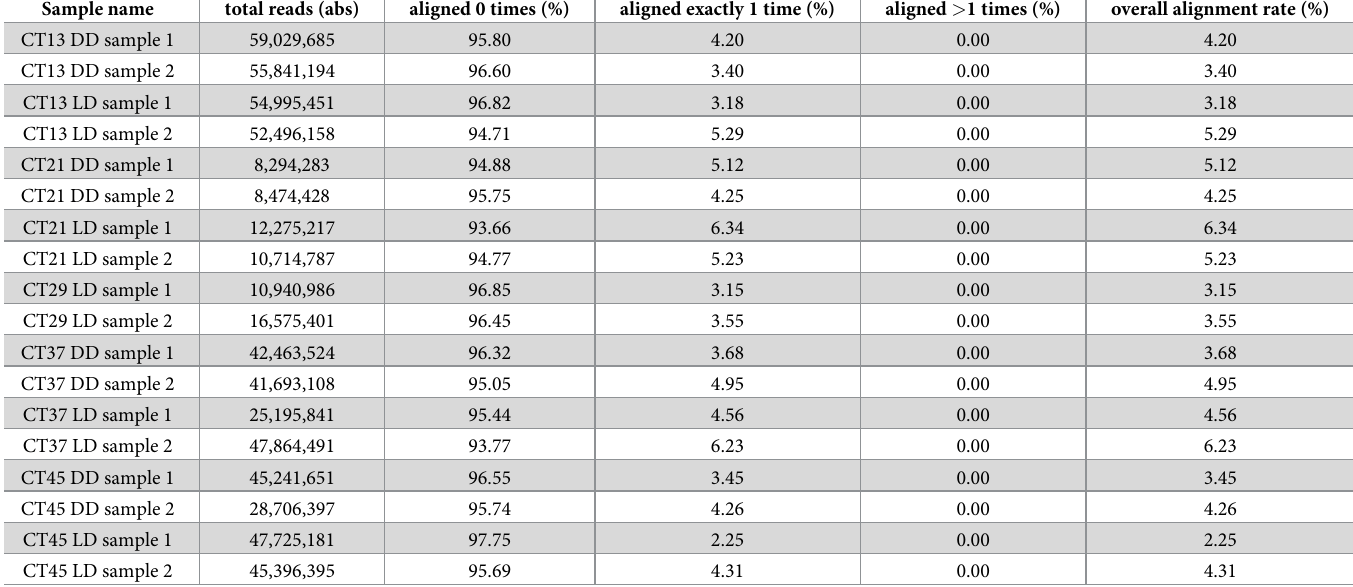
Table 2. Alignment rate to Nematostella vectensis mitocondria sequence (Version: Nematostella sp. JVK-2006 mitochondrion). Sample